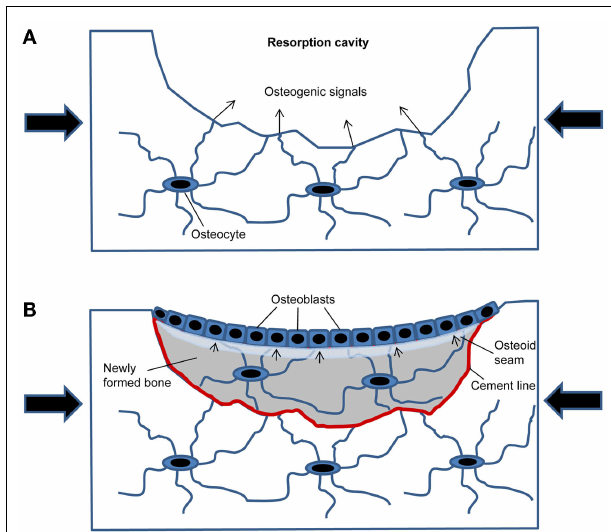
FIGURE 1 | Model of how mechanical strain within newly built bone packages induces coupling in cancellous bone remodeling . (A) After osteoclastic bone resorption has been completed, the resorption cavity results in mechanical weakening and increased strain in the bone spicule when loaded (large arrows). Mechanosensing osteocytes detect the increased strain and secrete osteogenic factors to induce osteoblastic bone formation. (B) Filling of the resorption cavity is controlled by mechanosensing in osteocytes embedded within the newly formed bone, signaling (small arrows) to osteoblasts on the bone